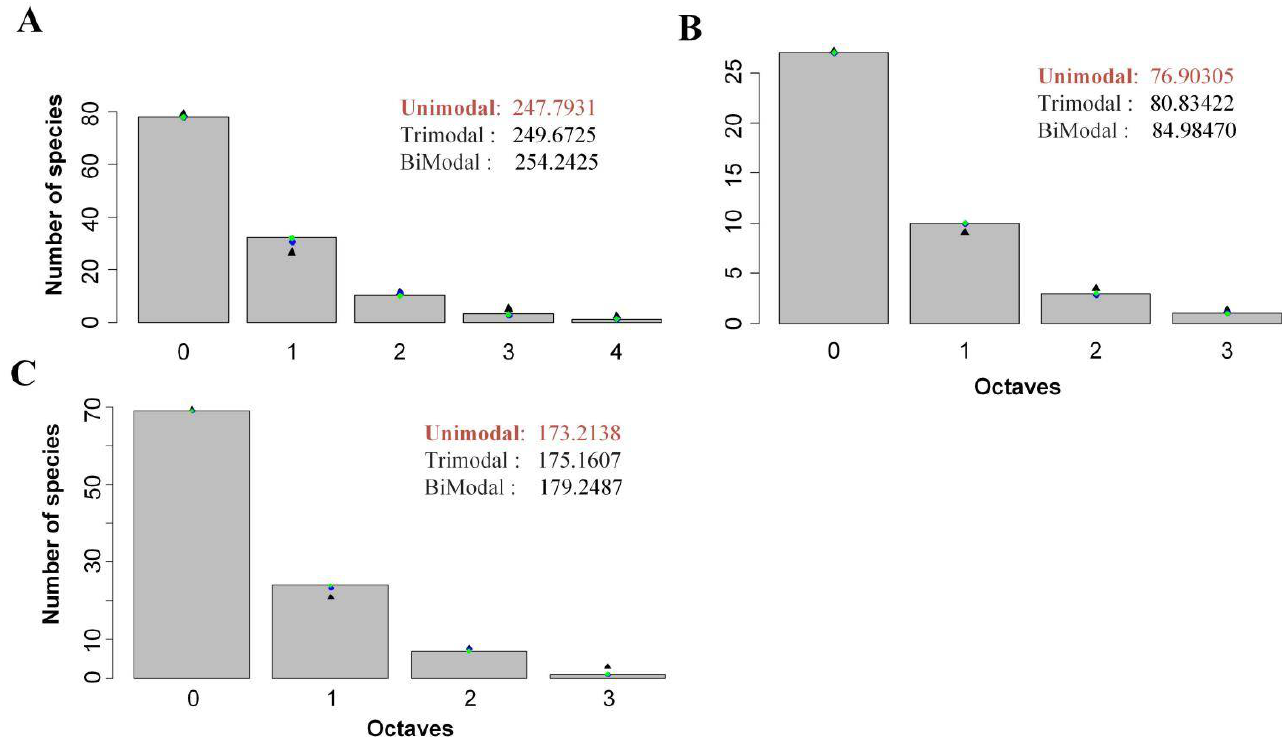
Figure 4. Fitting plots of the unimodal (black), bimodal (blue), and trimodal (green) gambin models. ( A – C ) represent the all, artificial disturbance and natural plots.